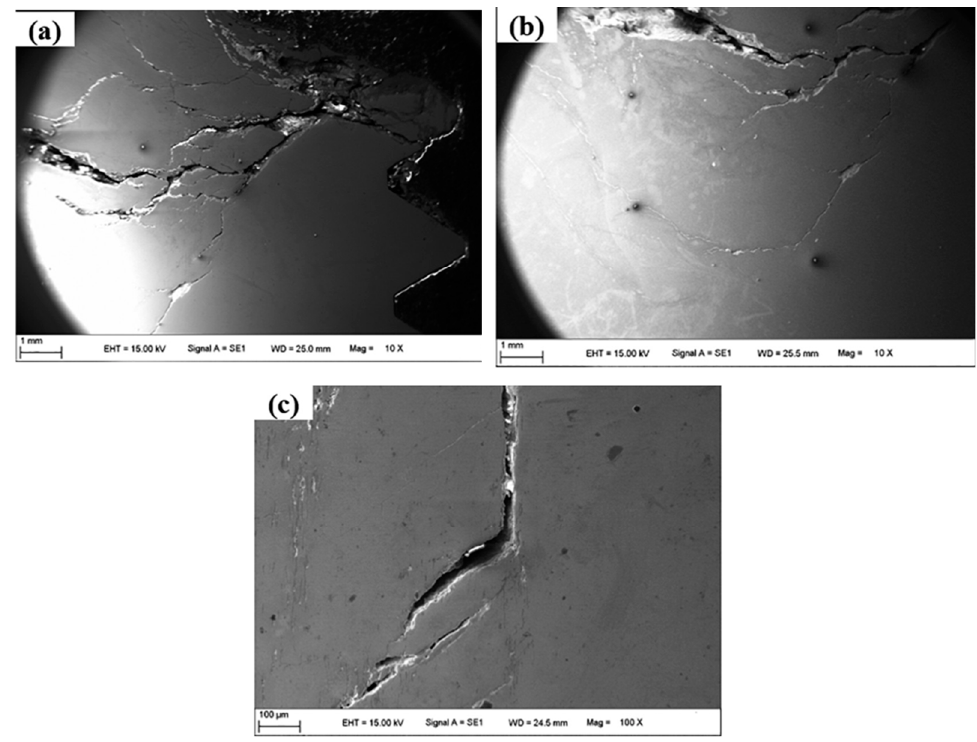
Figure 14. Microscopic images of cracks on the axial plane of the broken bolt: ( a ) branch cracks on the right of the axial plane, ( b ) cracks present in a mid-axial plane and ( c ) magnified branch cracks [96].